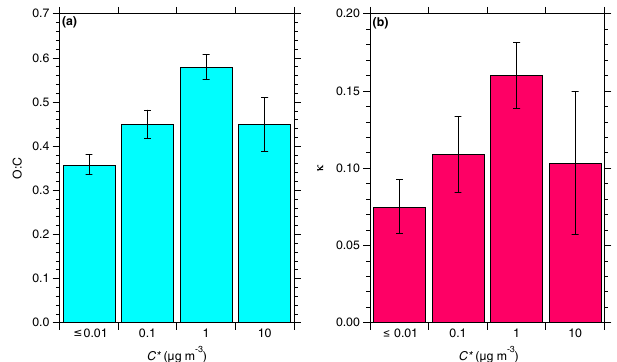
Figure 6. The estimated mass fractions for each volatility bin as a function of TD temperature for Experiment 1. Red represents the C ∗ = 0.01µgm − 3 bin, green the C ∗ = 0.1µgm − 3 bin, blue the C ∗ = 1µgm − 3 bin, and black the C ∗ = 10µgm − 3 bin.